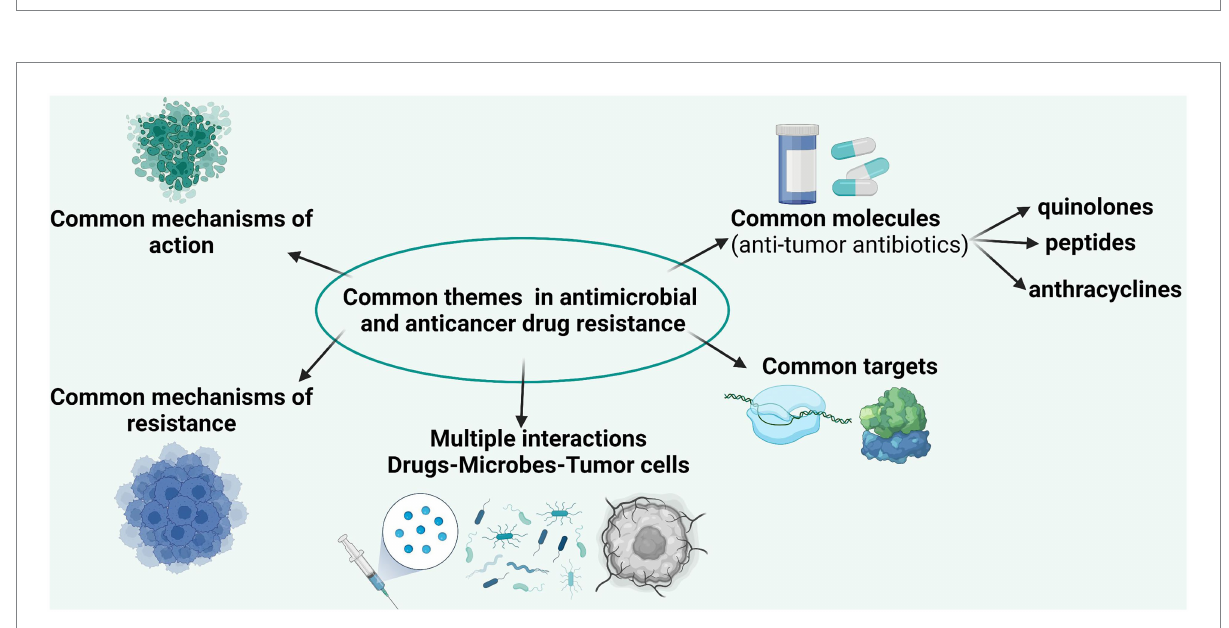
FIGURE 2 Comparative representation of the main targets, mechanisms of action, and mechanisms of resistance in bacterial and tumoral cells.